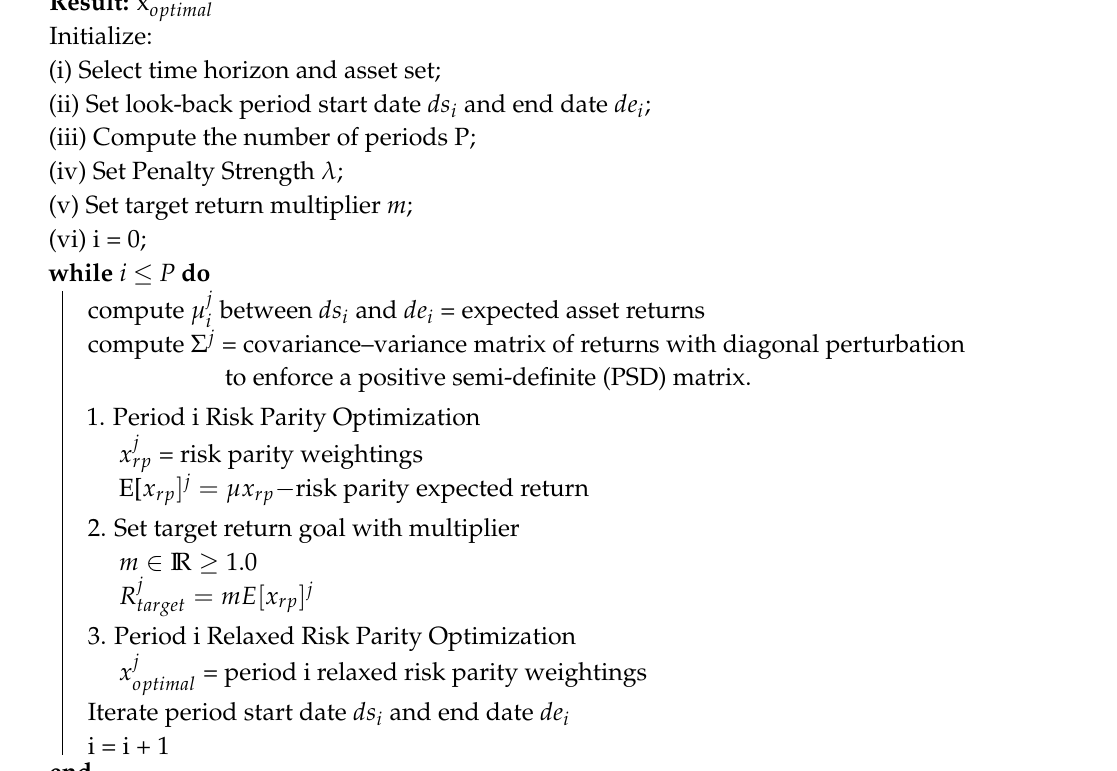
Algorithm 1: Multi Period Out-of-Sample